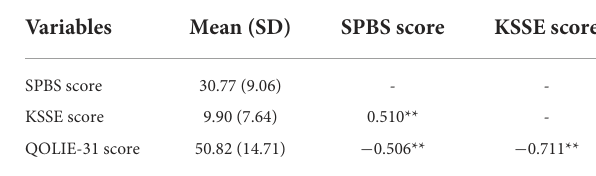
TABLE 3 Correlation analysis among SPBS score, KSSE score, and QOLIE-31 score in adult epilepsy patients ( N =